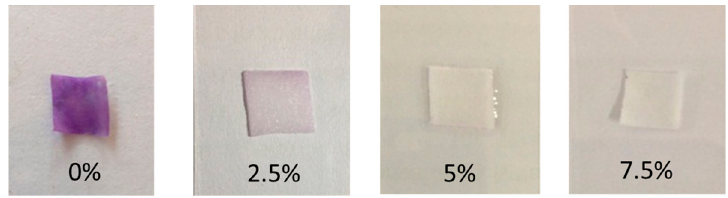
Figure 7. AHMT qualitative tests results for degradation of formaldehyde films.